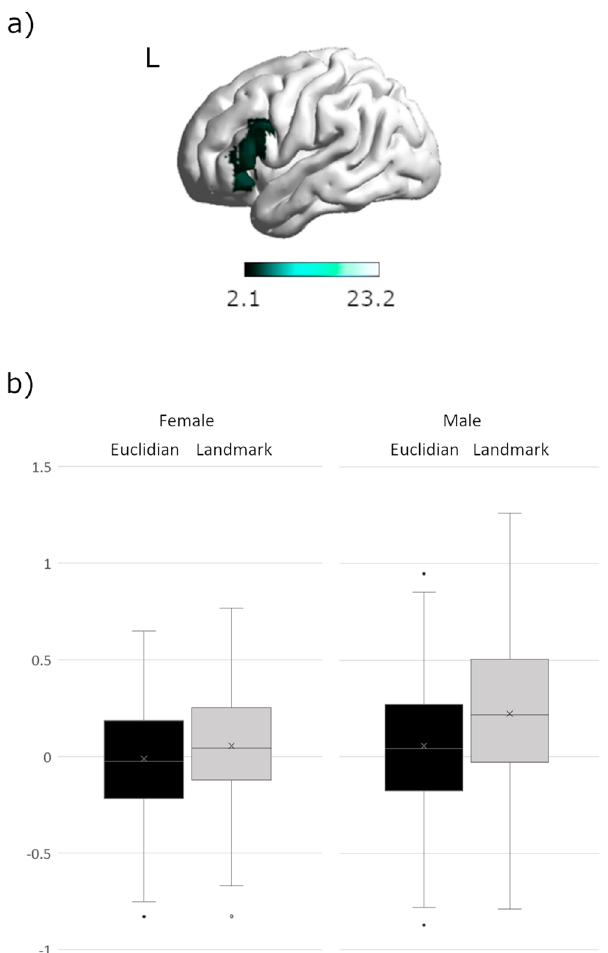
Fig. 4 Interaction between sex and strategy in the left inferior frontal gyrus. a Differential activation for men during landmark compared to Euclidian navigation in the left inferior frontal gyrus. b Men showed signi fi cantly stronger activation during landmark navigation, but not during Euclidian navigation. Error bars represent standard errors, N =